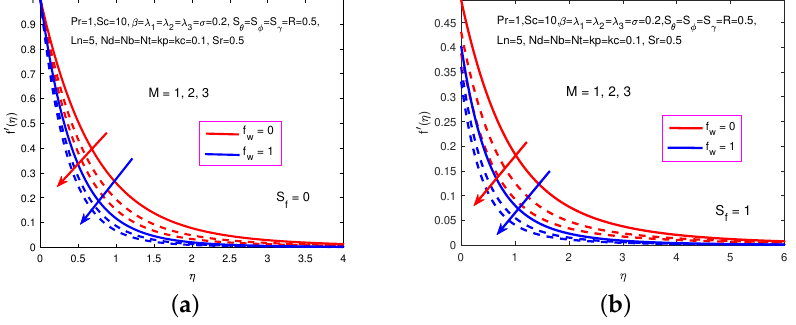
Figure 2. Influence of M and f w on f (cid:48) . ( a ) No hydrodynamic slip. ( b ) With hydrodynamic slip.